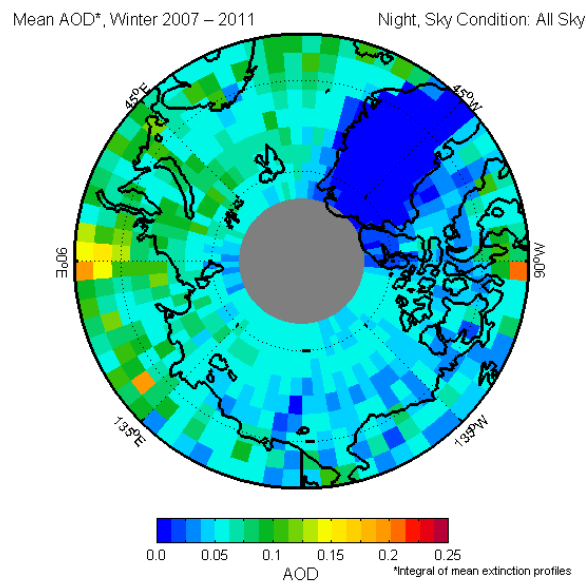
Fig. 12. Mean 532nm AOD in the Arctic, DJF 2007–2011, night- time.